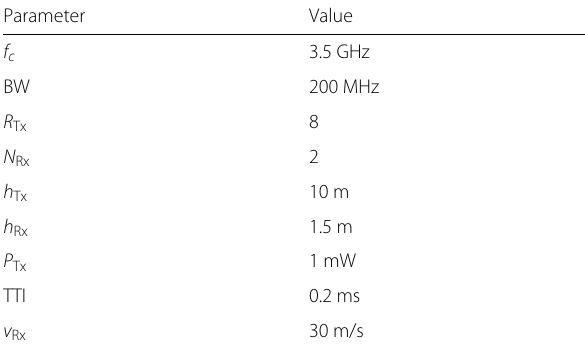
Table 3 Parameter settings